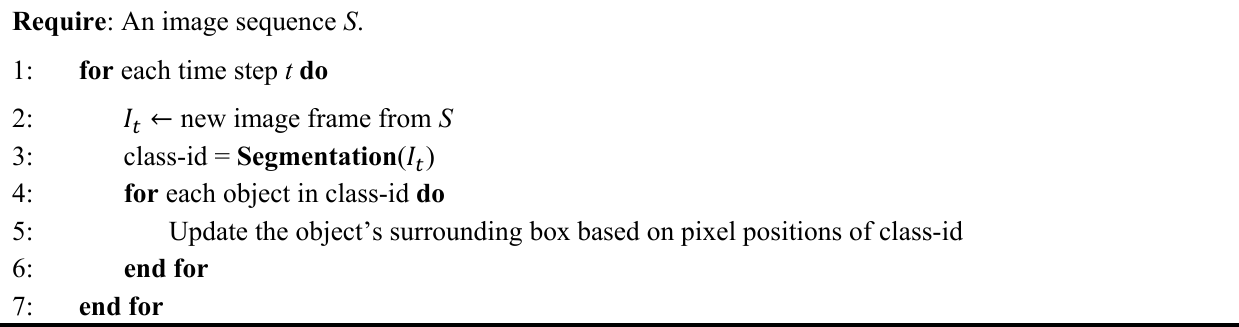
Algorithm 2. The tracking algorithm used in the